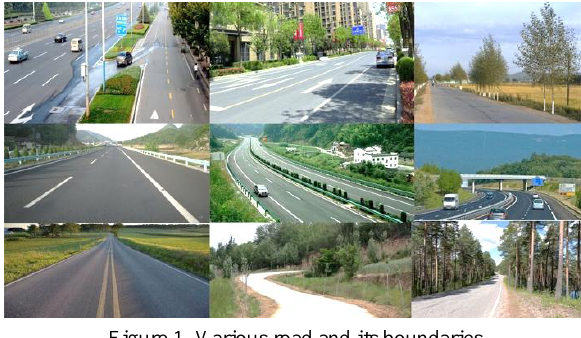
Figure 1. Various road and its